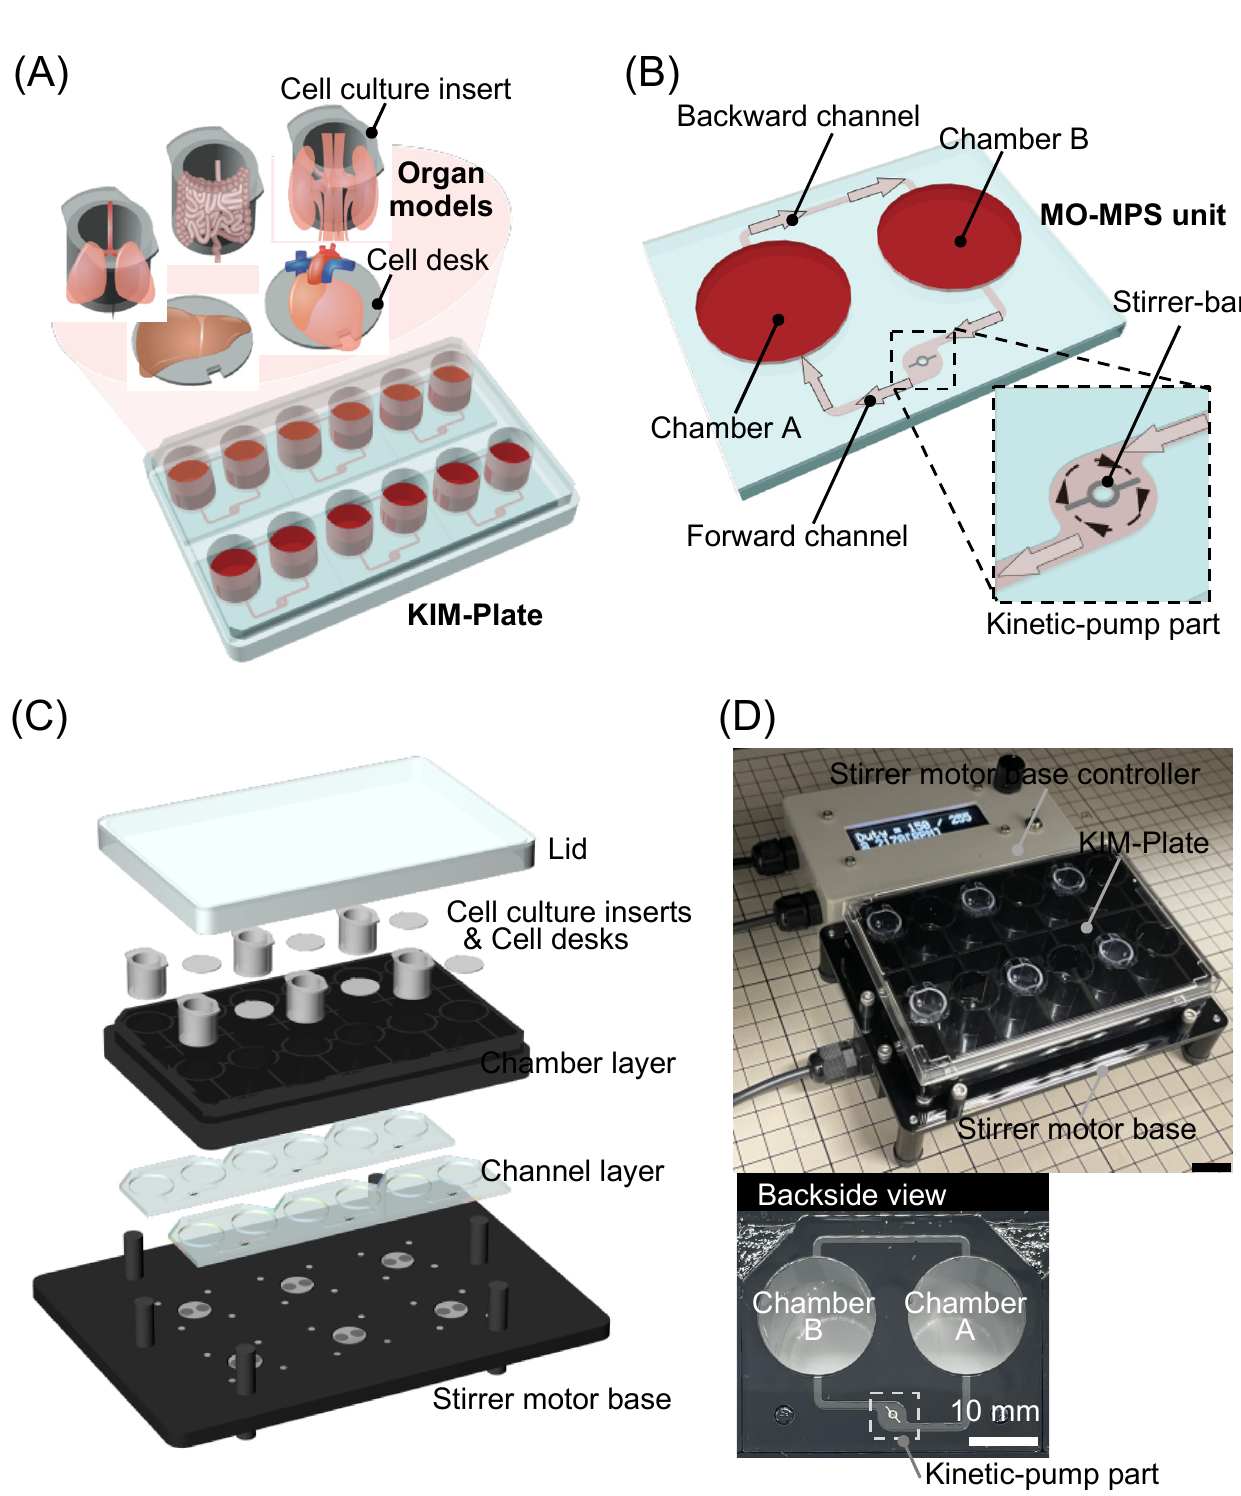
Figure 1. Kinetic pump integrated microfluidic plate (KIM-Plate) for multiorgan cell culture. ( A ) Conceptual diagram of the KIM-Plate. The KIM-Plate has a simple structure mimicking a 24-well plate, allowing easy handling. ( B ) The multiorgan MPS (MO-MPS) unit consists of two culture chambers and microfluidic channels. The stirrer-based kinetic pump is integrated in a forward channel for medium perfusion. ( C ) The KIM-Plate consists of a lid, a chamber layer, and a channel layer and is set on a stirrer motor base to control the kinetic pump and perfuse culture medium. ( D ) Photograph of the KIM-Plate and stirrer motor base system. The KIM-Plate was fabricated by laser fusion of the polystyrene channel and chamber layers. Motor rotation of the stirrer motor base can be controlled by a controller.